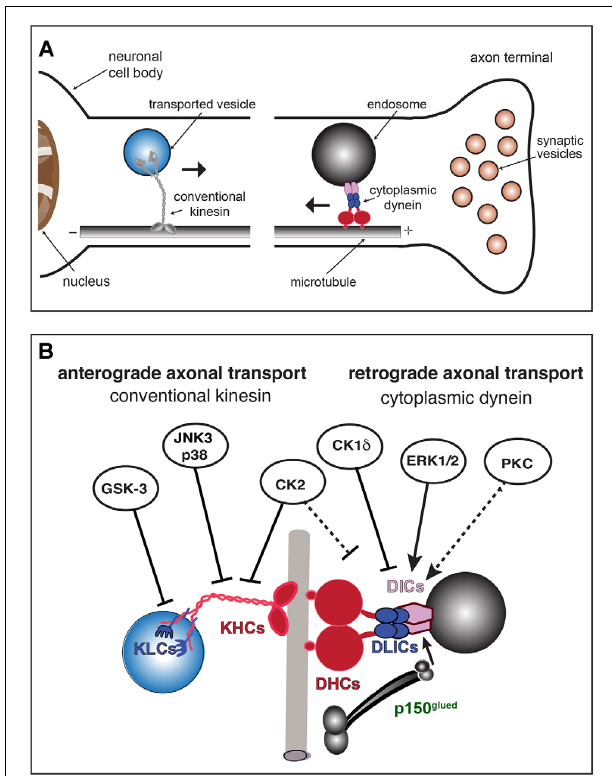
FIGURE 1 | Conventional kinesin and cytoplasmic dynein (CDyn): Transport of cargo, subunit components, and regulation by protein kinases. (A) Anterograde fast axonal transport (FAT; represented by → ) of membrane-bounded organelles (MBOs) is carried out by plus-end directed microtubule-based motors of the kinesin superfamily. Among those, conventional kinesin is the most abundant in mature neurons. Conventional kinesin moves a wide variety of MBOs from their location of synthesis and packaging in the neuronal soma to spatially discrete axonal subcompartments, including presynaptic terminals. The minus-end directed motor, cytoplasmic dynein, drives retrograde FAT of MBOs containing degraded materials, defective organelles, or signaling endosomes back to the neuronal soma ( ← ). (B) Subunit organization of major microtubule-based motors. The conventional kinesin holoenzyme (left) is a heterotetramer composed of two kinesin heavy chain (KHC) and two light chain (KLC) homodimers. Cytoplasmic dynein (right) exists as a multisubunit protein complex formed by at least two heavy chains (DHCs, in red), two intermediate chains (DICs, in purple), four light intermediate chains (LICs, in blue), and several light chains (LCs, not shown). The dynactin subunit P150 Glued (in green) interacts with both DICs and microtubules and has been proposed to modulate the processive movement of the CDyn complex. Kinases with established roles in the regulation of anterograde and retrograde FAT are indicated. Solid arrows indicate specific motor protein subunits targeted by each kinase. Whether PKC activates retrograde FAT through cytoplasmic dynein phosphorylation has not yet been established (dashed arrow). Straight arrows indicate activation of retrograde FAT (by ERK1/2 and PKC). Blunt-ended arrows indicate inhibitory effects of kinases on either anterograde or retrograde FAT. By altering the activity of kinases involved in the regulation of FAT and motor protein phosphorylation, neurotropic viruses may promote FAT abnormalities and other cellular processes, eventually triggering neuronal dysfunction and pathology.